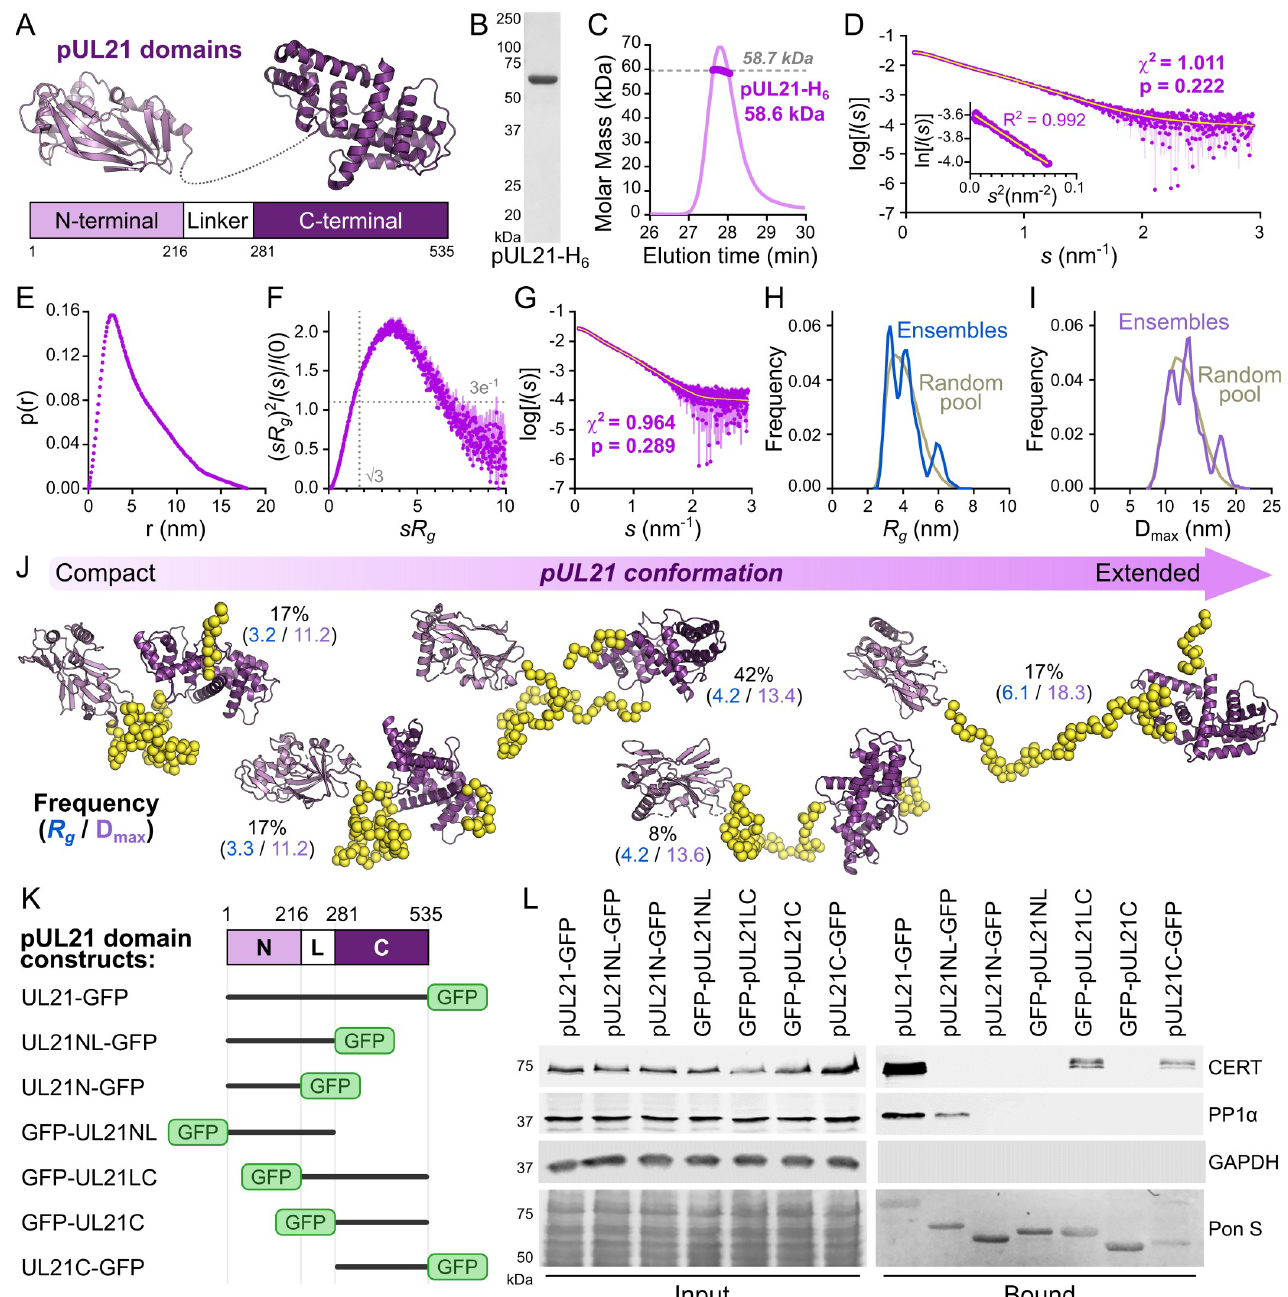
Fig 2. The C-terminal domain of pUL21 binds CERT whereas the N-terminal domain and disordered linker bind PP1. ( A ) Schematic representation of pUL21, with crystal structures of the N- and C-terminal domains [24,25] shown in in light and dark purple, respectively. ( B ) Coomassie-stained SDS-PAGE of full-length pUL21-H 6 purified following bacterial expression. ( C ) SEC-MALS of purified pUL21-H 6 . Weight-averaged molar mass (thick line) is shown across the SEC elution profile (normalised differential refractive index, thin lines) with the expected molar mass for monomeric pUL21-H 6 shown as a dashed line. ( D ) SAXS profile (purple) measured from pUL21-H 6 and the corresponding Guinier plot ( sR < 1.15; inset). The Guinier plot is linear (yellow line), as expected for g an aggregate-free system. The reciprocal-space fit of the p ( r ) profile to the SAXS data is shown a yellow trace. χ 2 , fit quality; p, Correlation Map (CorMap) probability of systematic deviations between the model fit and the scattering data [93]. ( E ) The real-space distance distribution function, p ( r ), computed from the experimental SAXS profile. ( F ) Dimensionless Kratky plot of the SAXS data. The expected maximum of the plot for a compact protein is shown as grey p dotted lines ( sR g = 3, ( sR g ) 2 I ( s )/ I(0) = 3 e -1 ). ( G ) Fit to the SAXS profile of a refined pUL21-H 6 ensemble obtained by EOM. The ensemble comprises conformational states of the pUL21 N- and C-terminal domains [24,25] joined by a flexible linker. ( H , I ) Comparison of the frequency distributions of R ( H ) g and D max ( I ) from an initially generated random pool of structures (grey) and the refined EOM ensemble (blue and violet, respectively) indicate that, in